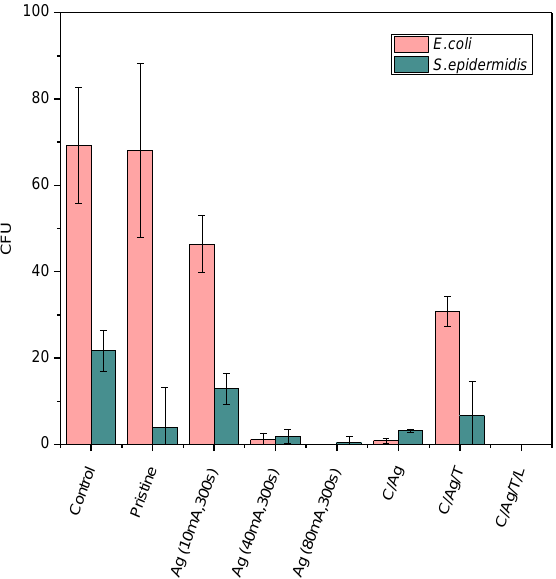
Figure 9. The number of colony-forming units (CFU) of S. epidermidis and E. coli grown on agar plates inoculated with bacteria in contact with the evaluated samples for 4 h. The samples were the following: PDMS with an Ag layer modified at the deposition time of 300 s and different currents of 10, 40, and 80 mA, samples with a C/Ag layer combination and subsequent temperature treatment or eventually laser modification and pristine PDMS samples were tested. The prepared samples were compared with the control.